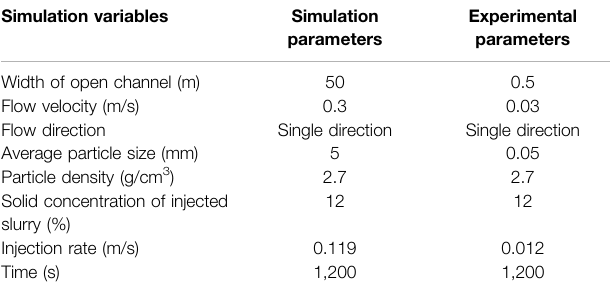
TABLE 1 | Parameters of hydraulic transport simulation